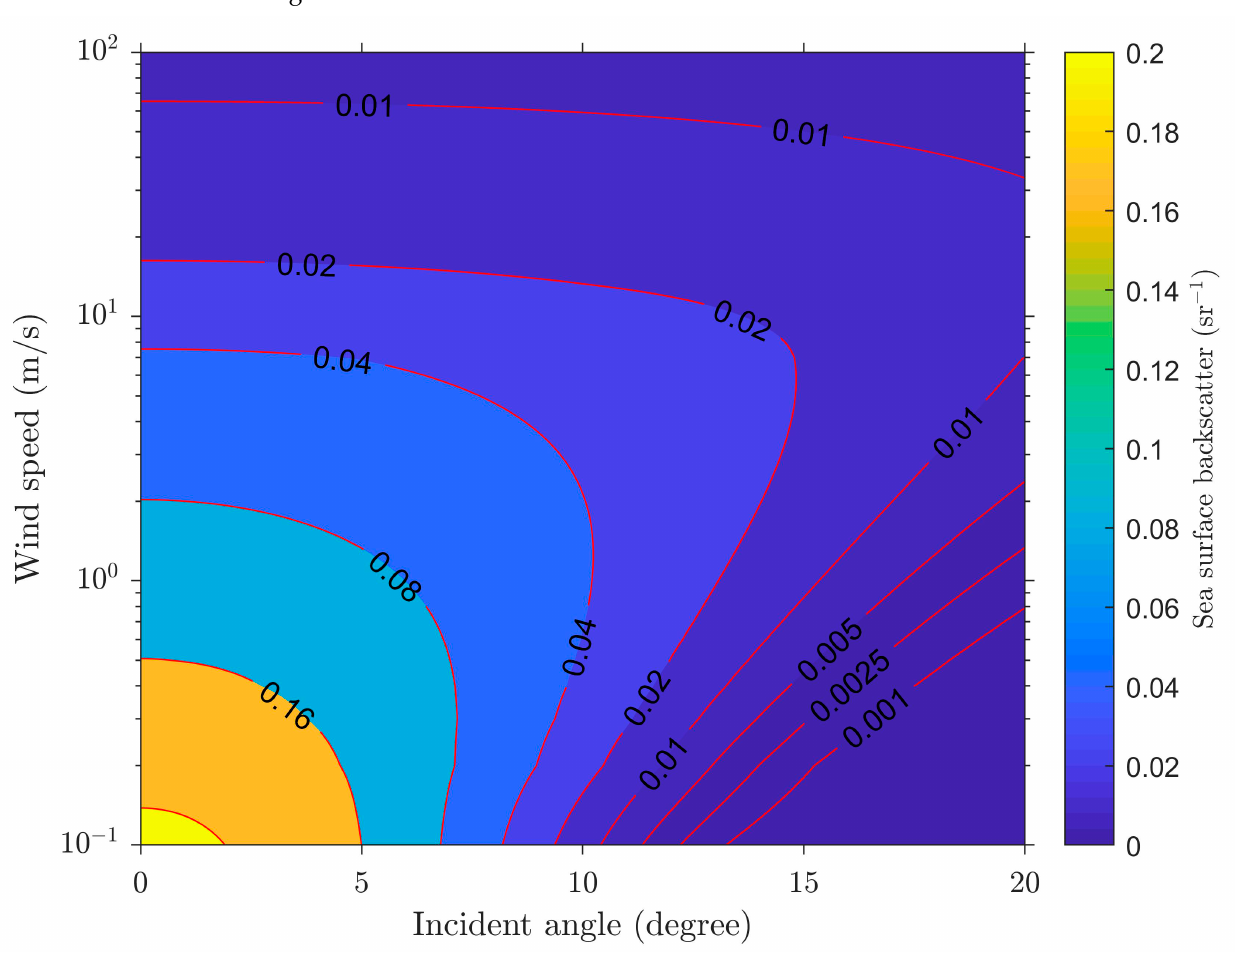
Figure 17. Sea surface backscatter versus incident angle.